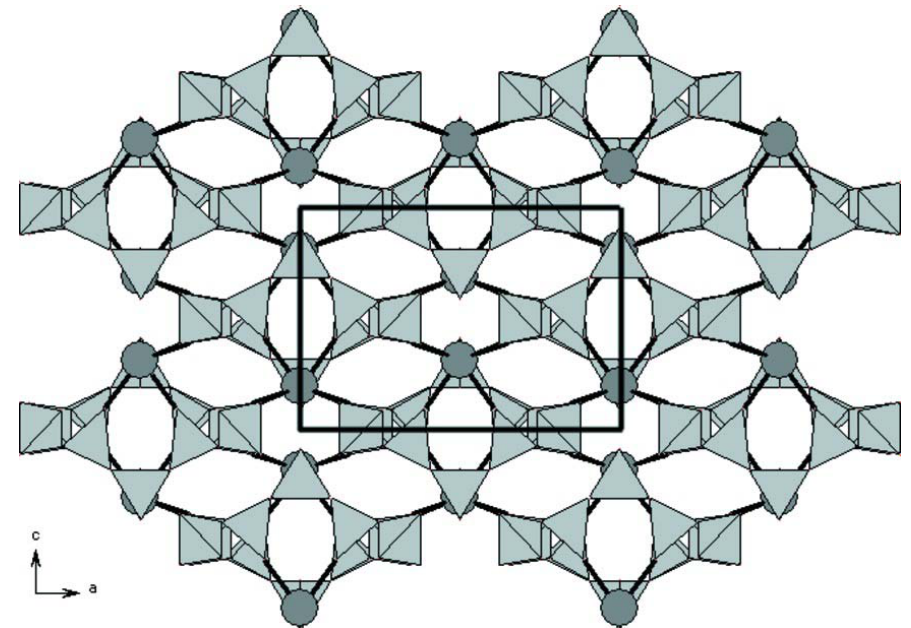
Figure 2 Projection of the structure along the b axis. The tetrahedra represent PO cations.